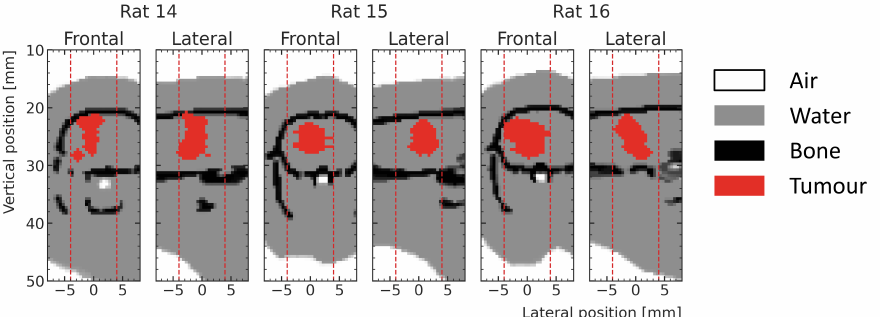
Figure 4. Frontal and lateral slices at the center of the ML prediction regions (red dotted lines) showing exemplary tumors (red) in the respective phantoms (white—air, gray—water and black—bone) of the three test rats used in the testing.